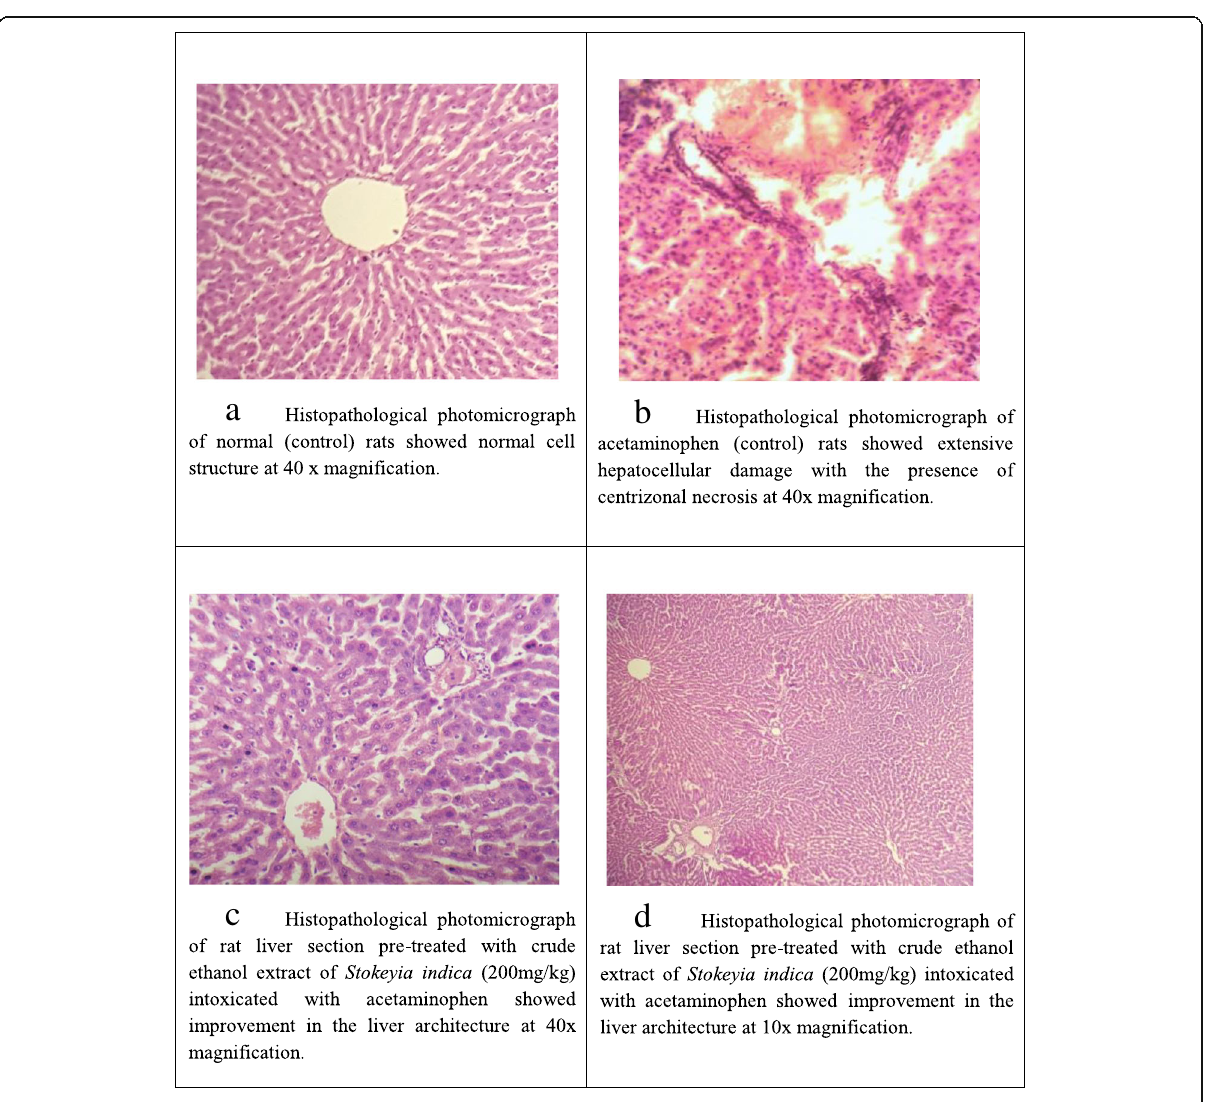
Fig. 1 ( a , b , c , d ) Histopathology analysis of liver sections in normal, acetaminophen treated and Stokeyia indica (40X,10X) treated rats model. a Histopathological photomicrograph of normal (control) rats showed normal cell structure at 40 x magnification. b Histopathological photomicrograph of acetaminophen (control) rats showed extensive hepatocellular damage with the presence of centrizonal necrosis at 40x magnification. c Histopathological photomicrograph of rat liver section pre-treated with crude ethanol extract of Stokeyia indica (200mg/kg) intoxicated with acetaminophen showed improvement in the liver architecture at 40x magnification. d Histopathological photomicrograph of rat liver section pre-treated with crude ethanol extract of Stokeyia indica (200mg/kg) intoxicated with acetaminophen showed improvement in the liver architecture at 10x